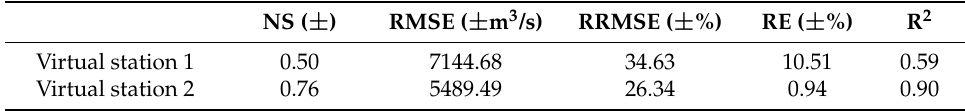
Figure 13. The estimated (red points) and observed (black line) discharges during 2003–2008. Table 3. The performance evaluation results of discharge estimation for virtual station 1 (near Hankou station) and virtual station 2 (near Datong station).